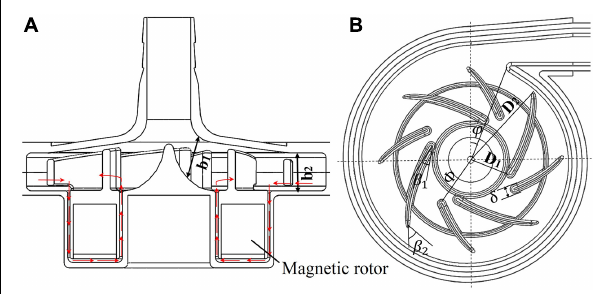
FIGURE 1 | (A) Schematic of the maglev blood pump model, red arrows indicate flow direction of the secondary flow path; (B) baseline design of the impeller and volute, showing main design parameters.